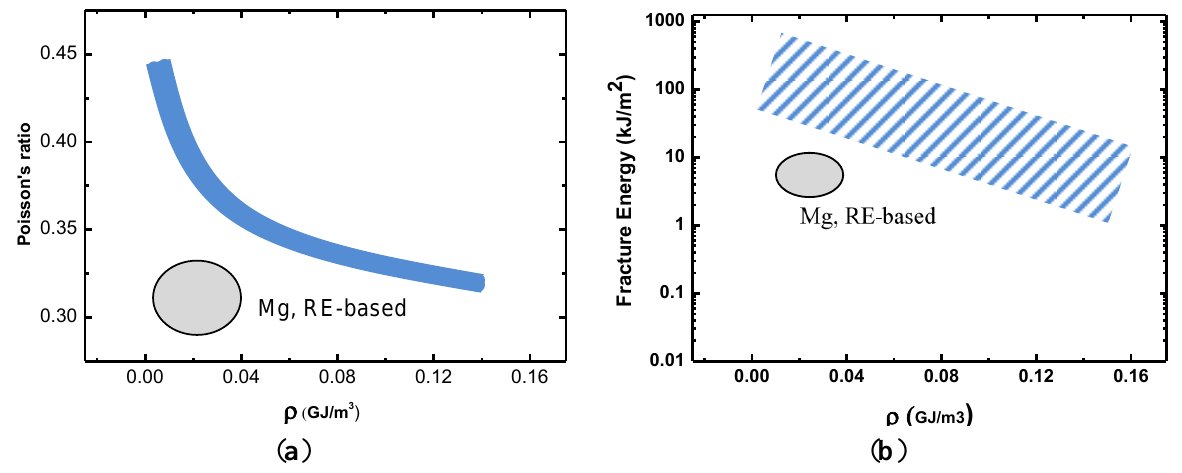
Figure 10. Schematic plots based on the work in [55], showing inverse correlation between STZ barrier energy density and ( a ) Poisson’s ratio and ( b ) fracture